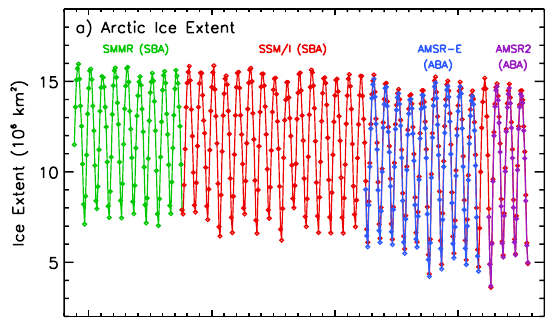
Figure 3. Monthly ice extents in the Northern Hemisphere as derived from SMMR (in green), SSM/I (in red), AMSR-E (in blue) and AMSR2 (in purple) sensors.